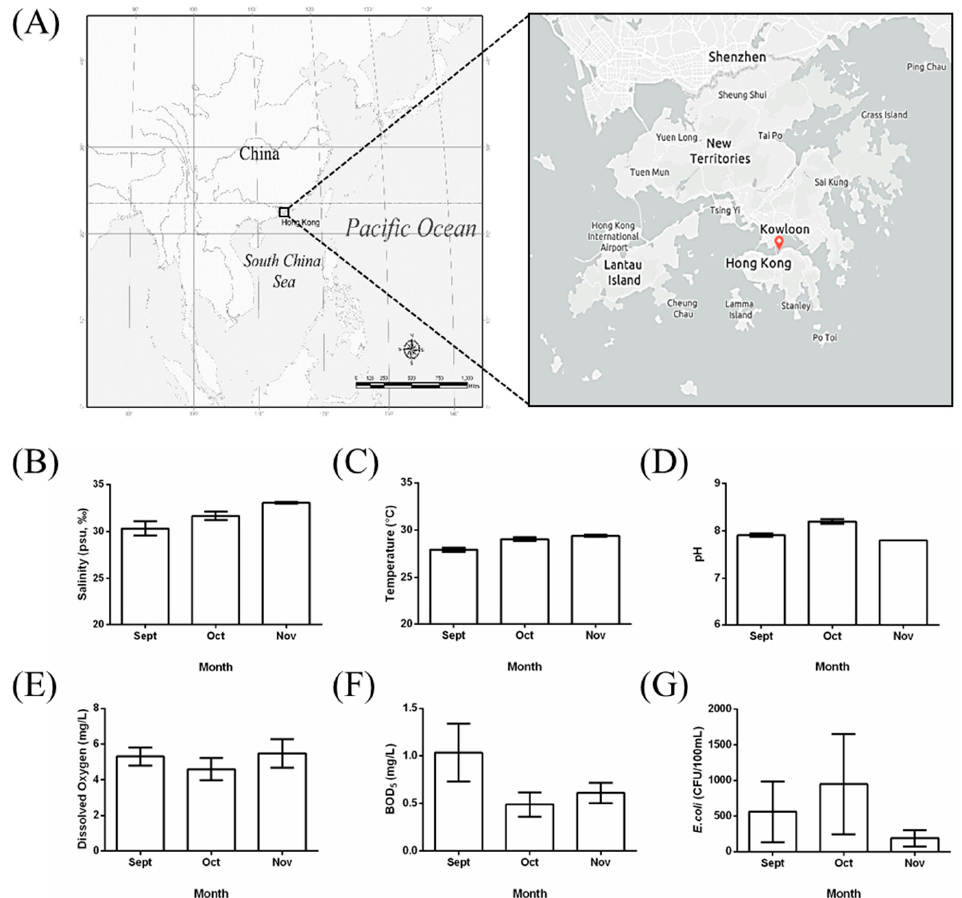
Figure 1. ( A ) The location of the subtropical seawater sampling site on the coastline of southern China, shown on a geographical map. The basic physicochemical properties are shown, including ( B ) the salinity, ( C ) the temperature, ( D ) the acid/base values, ( E ) the dissolved oxygen concentration, ( F ) the five-day biochemical oxygen demand (BOD 5 ) values, and ( G ) the number of E . coli bacteria during the experimental period.